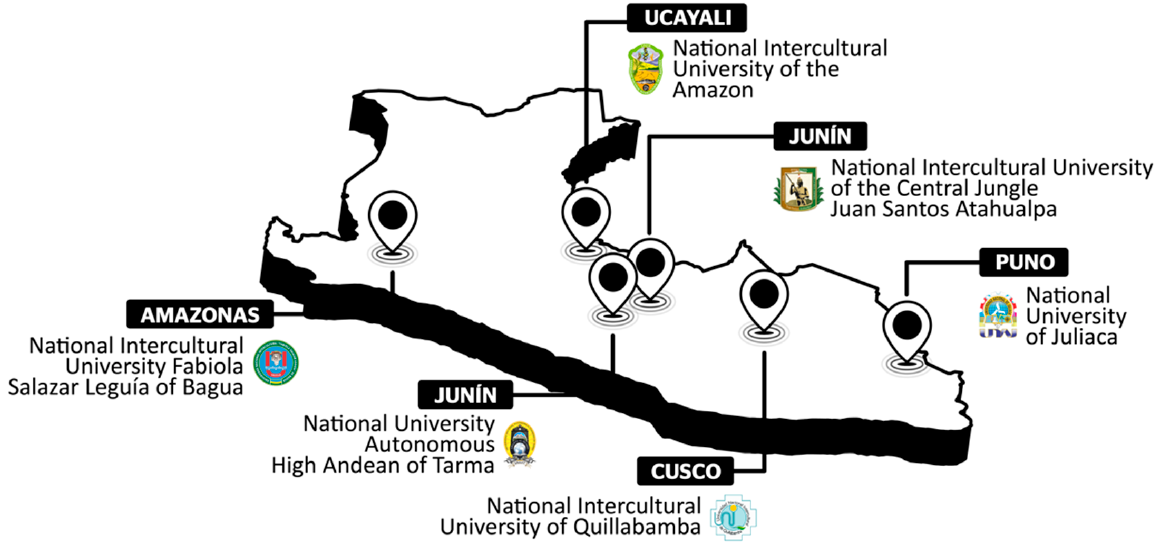
Figure 1. Map of the six Peruvian public universities. Note: Adapted from ([10], p. 2).